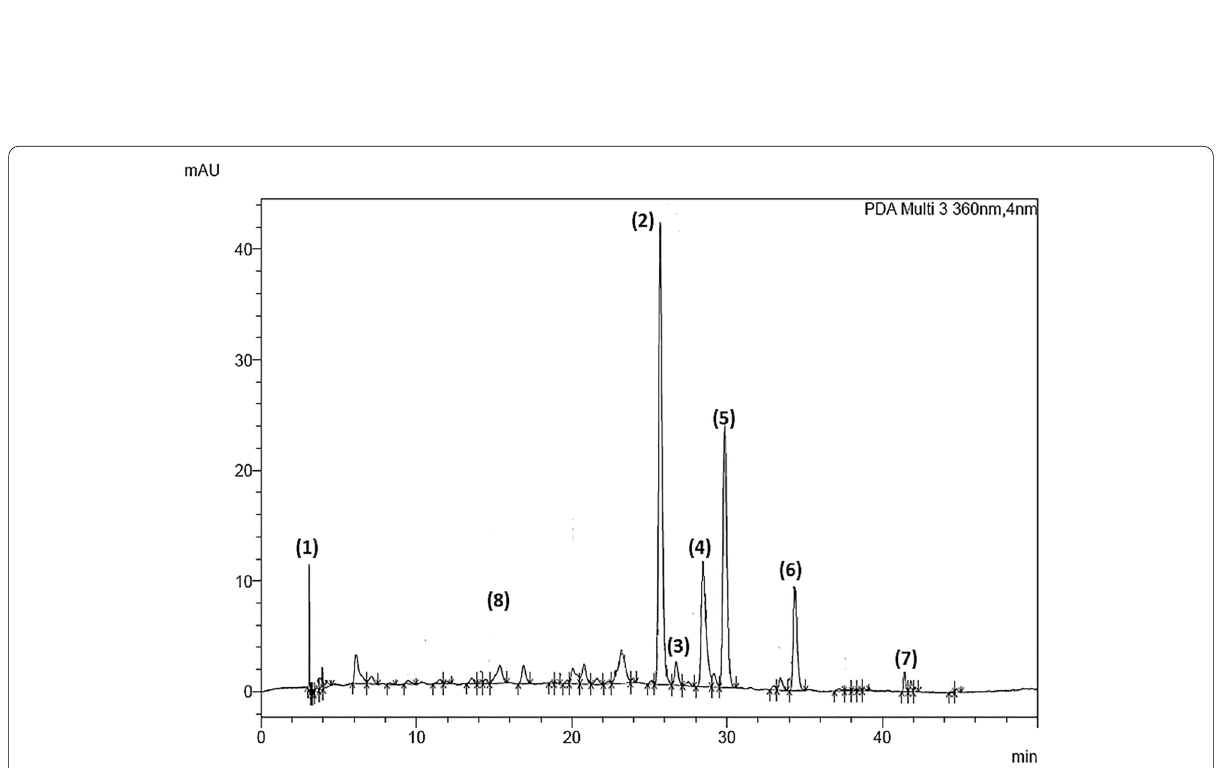
Fig. 3 Typical chromatogram of polyphenol‑rich extracts from the residues of three strawberry cultivars (360 nm wavelength). (1): tetragalloyl‑glucose isomer, (2): ellagic acid pentoside, (3): agrimoniin, (4): free ellagic acid, (5): quercetin‑3‑ O ‑glucuronide, (6): kaempferol‑3‑ O ‑glucuronide, (7): kaempferol pentoside, (8): pelargonidin‑3‑ O